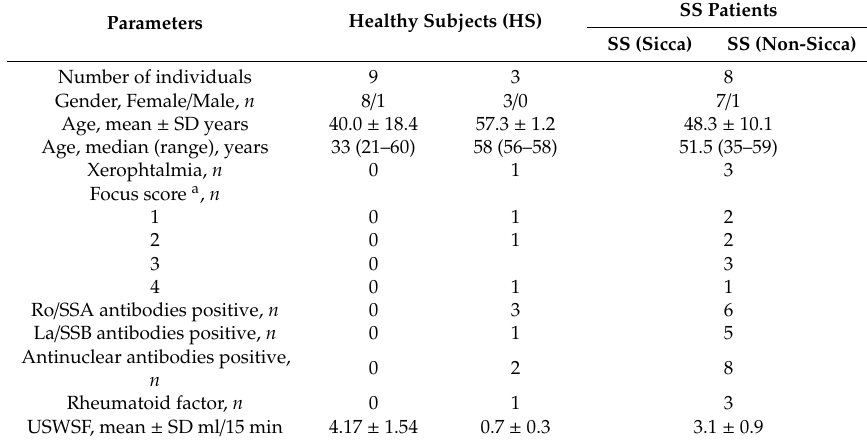
Table 2. Demographic, serological and histological characteristics of the SS (sicca), SS (non-sicca) patients and HS participating in the microarray